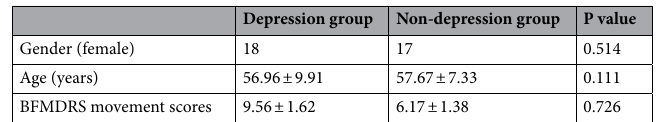
Table 2. Clinical data for Meige syndrome patients with and without